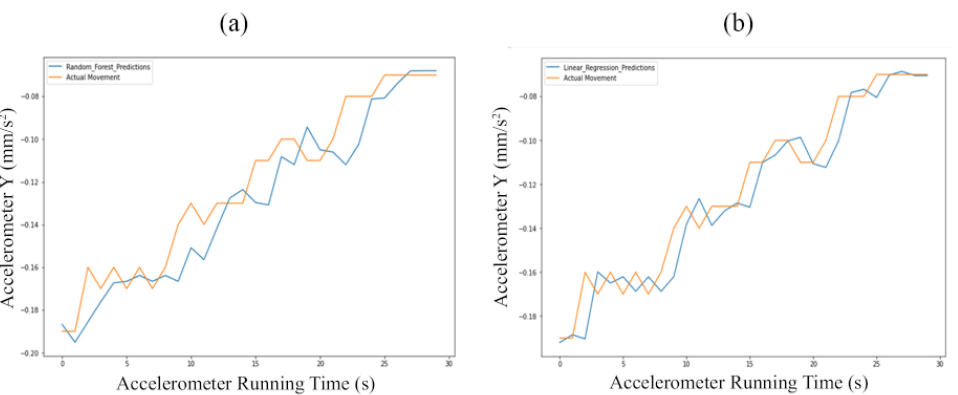
Figure 11. Data prediction is wrong/end of lifecycle condition using ( a ) RF regression method, ( b ) LR regression method.